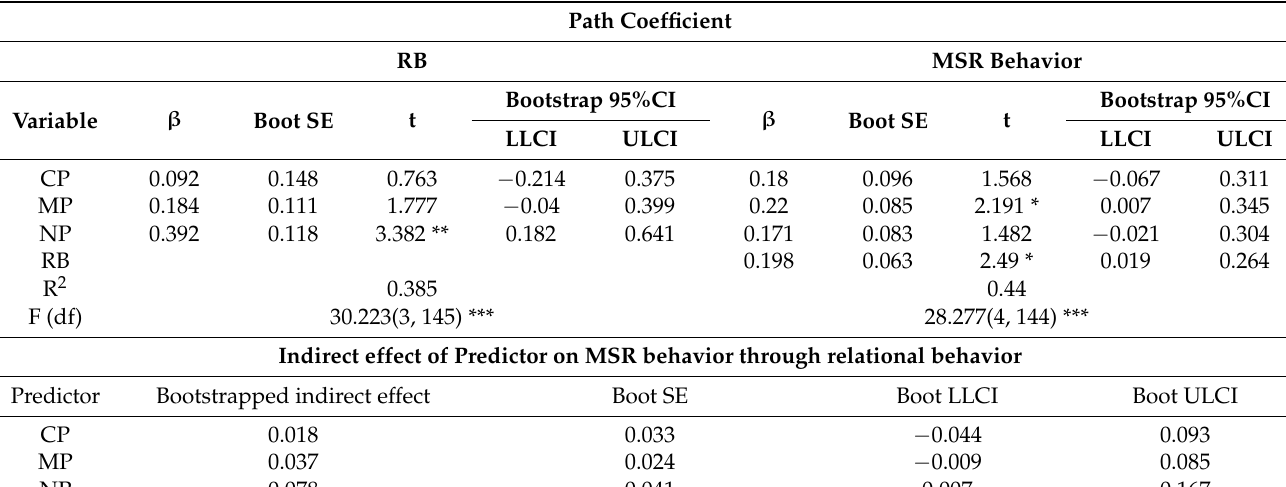
Table 5. Summary of Model